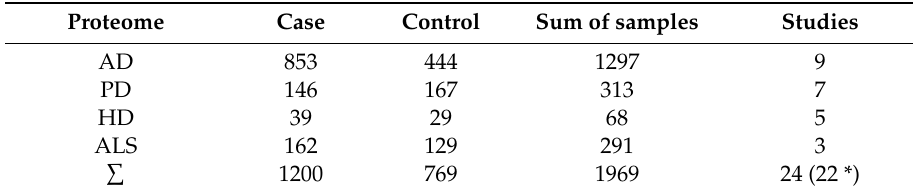
Table 2. Overview of the number of cases, controls and the total number of studies per disease throughout all analyzed proteome studies. In total, data of 1969 samples were gathered from 22 studies analyzing proteomic data. * Two studies conducted experiments for AD and PD. Thus, in total proteomic data of 22 studies was used. Proteome Case Control Sum of samples Studies AD 853 444 1297